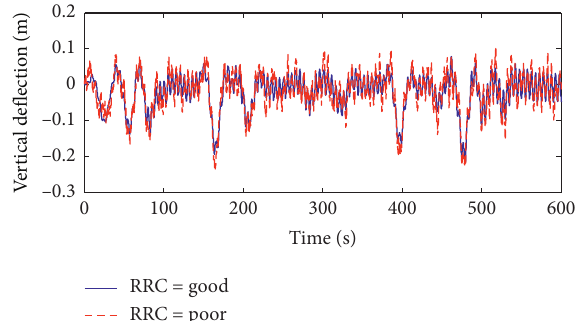
Figure 11: Vertical deflection histories of the critical point in the mid-span of the bridge girders in